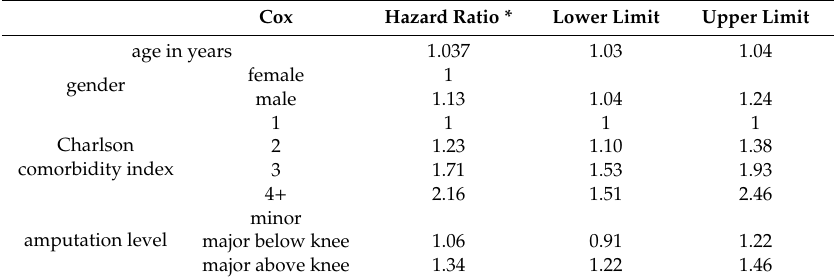
Table 3. Factors associated with dying among T2DM patients who had undergone a